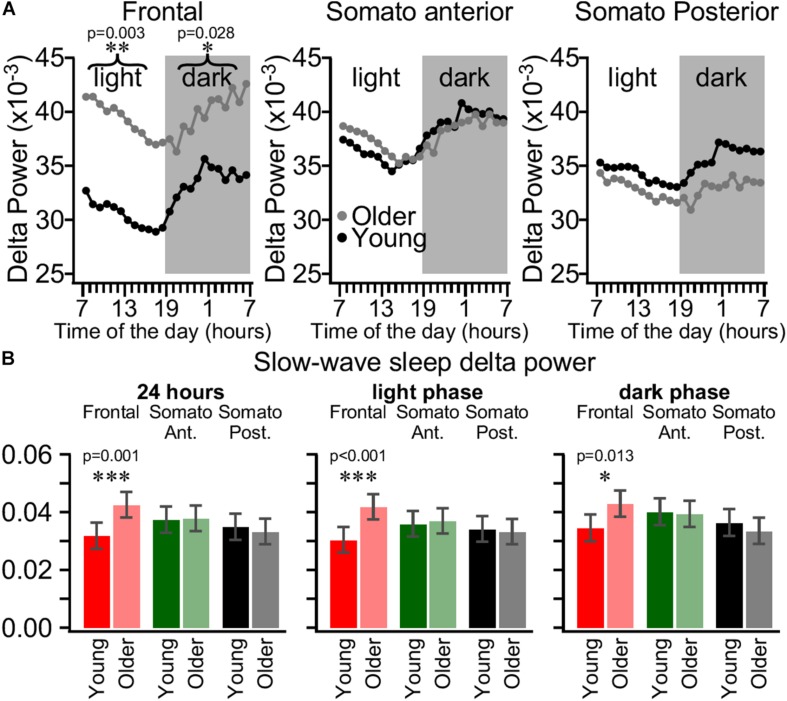
Area-specific daily SWS delta power dynamics is different in young and older mice. (A) Estimated mean delta power in SWS at each hour of the day for the frontal electrode (left panel), the somatosensory anterior electrode (middle panel), and somatosensory posterior electrode (right panel) for young (black circles, n = 99 days from eight mice) and older mice (gray circles, n = 67 days from nine mice). Printed values are estimated marginal means computed in two independent mixed linear models (one per light or dark phase) using factors of age, electrode, and time of the day. (B) Mean SWS delta power in frontal cortex (red), somatosensory anterior cortex (green), and somatosensory posterior cortex (black) for 24 h (left panel), light phase (middle panel), and dark phase (right panel) for young (bright colors) and older (light colors) mice. Error bars indicate the 95% confidence interval. Significant statistical differences are indicated by asterisk, ∗p < 0.05, ∗∗p < 0.01, *⁣∗∗p < 0.001.